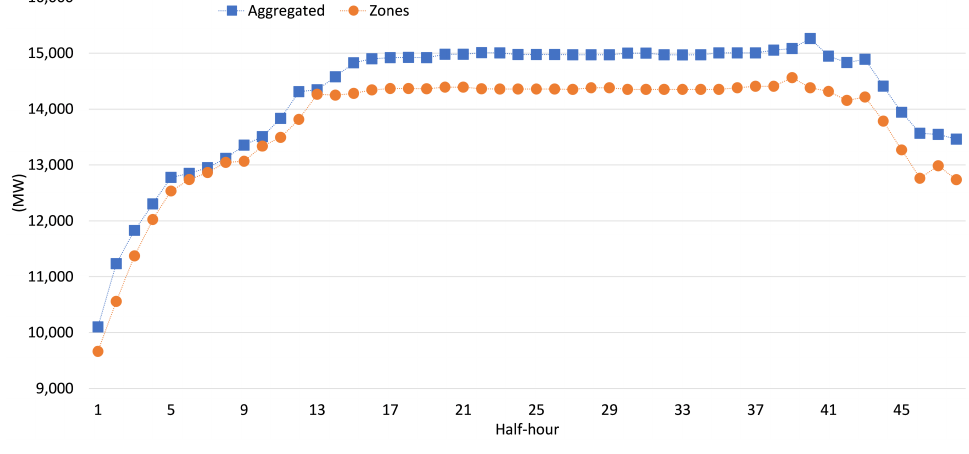
Figure 14. Thermal generation in Case 8 Trial 1.